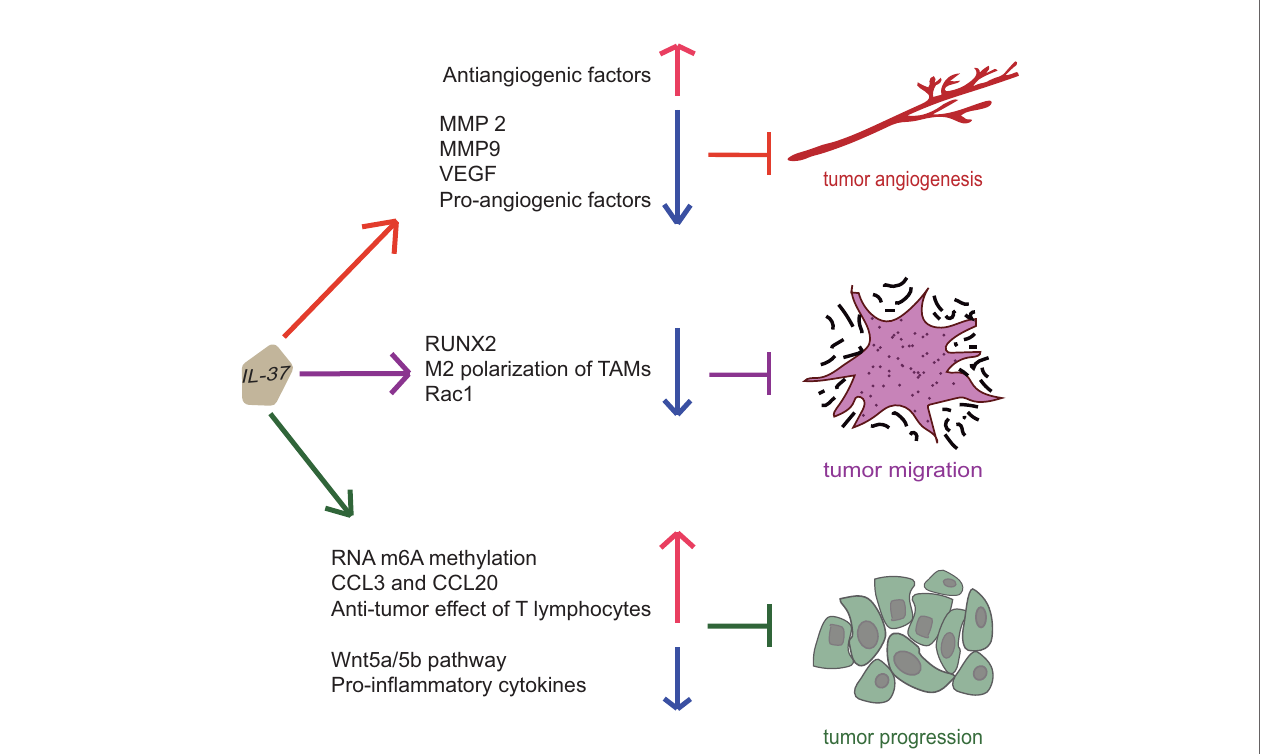
FIGURE 5 | Suppression of cancer by IL-37. IL-37 can induce an antiangiogenic effect on tumor by increasing the expression of antiangiogenic factors and reducing that of pro-angiogenic factors, MMP 2, MMP9 and vascular endothelial growth factor. Moreover, IL-37 can inhibit migration and invasion of the tumor by suppressing M2 polarization of tumor-associated macrophages, activation of Rac1, and expression of runt related transcription factor 2. Furthermore, IL-37 can inhibit tumor progression by promoting RNA m6A methylation, secretion of CCL3 and CCL20, and anti-tumor effect of T lymphocytes and inhibiting Wnt5a/5b pathway and pro- in fl ammatory cytokine production. Thus, IL-37 exerts inhibitory effects on tumor angiogenesis, migration and